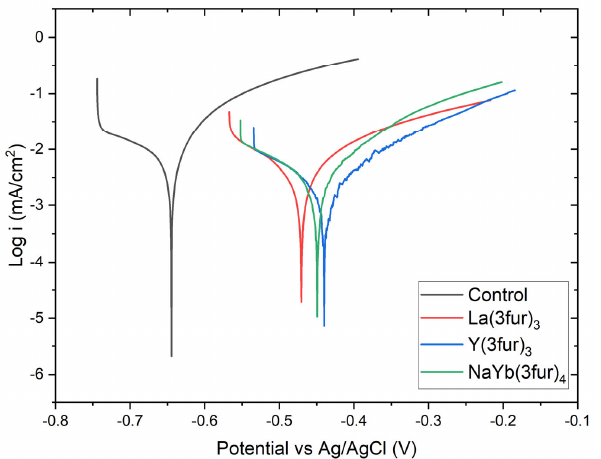
Figure 6. Representative potentiodynamic polarisation scans after 24 h for 0.01 M NaCl control, and solutions with 0.01 M NaCl and 800ppm of [Y(3fur) 3 (H 2 O) 2 ] n ( 1Y ), [La(3fur) 3 (H 2 O) 2 ] n ( 1La ) and [NaYb(3fur) 4 ] n ( 2Yb ).